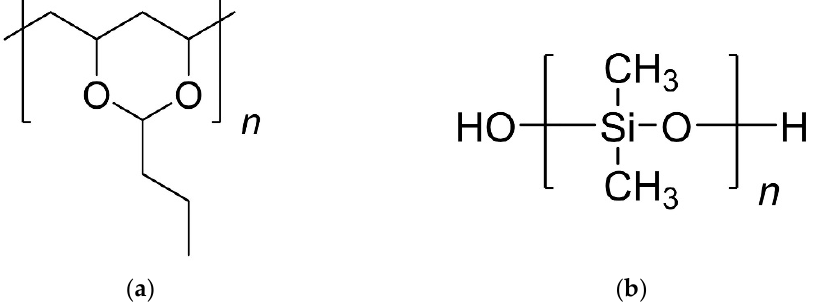
Figure 1. Structures of ( a ) Butvar B-98 and ( b ) PDMS-OH siloxanes.